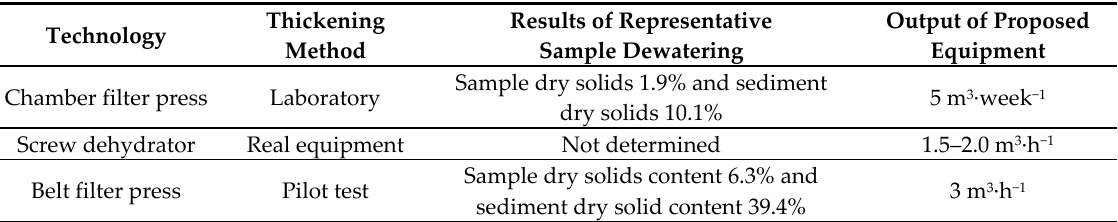
Table 2. Comparison of alternative soggy slag sludge thickening equipment.